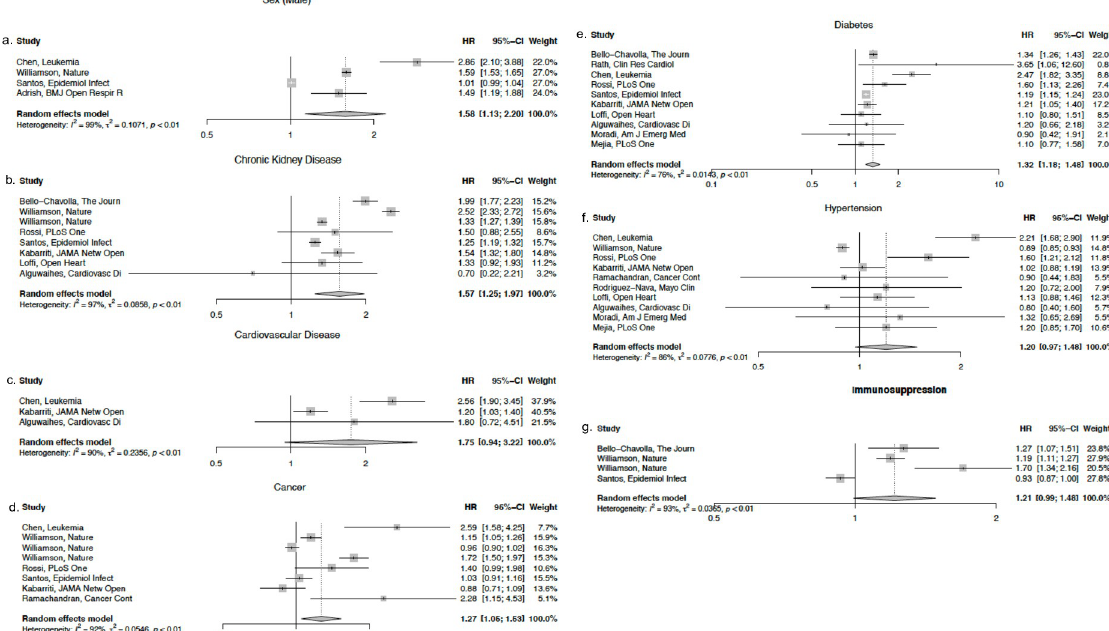
Fig 3. a-g. Forest plots for individual study estimates and pooled estimates of risk factors associated with COVID-19 related mortality in studies using Cox